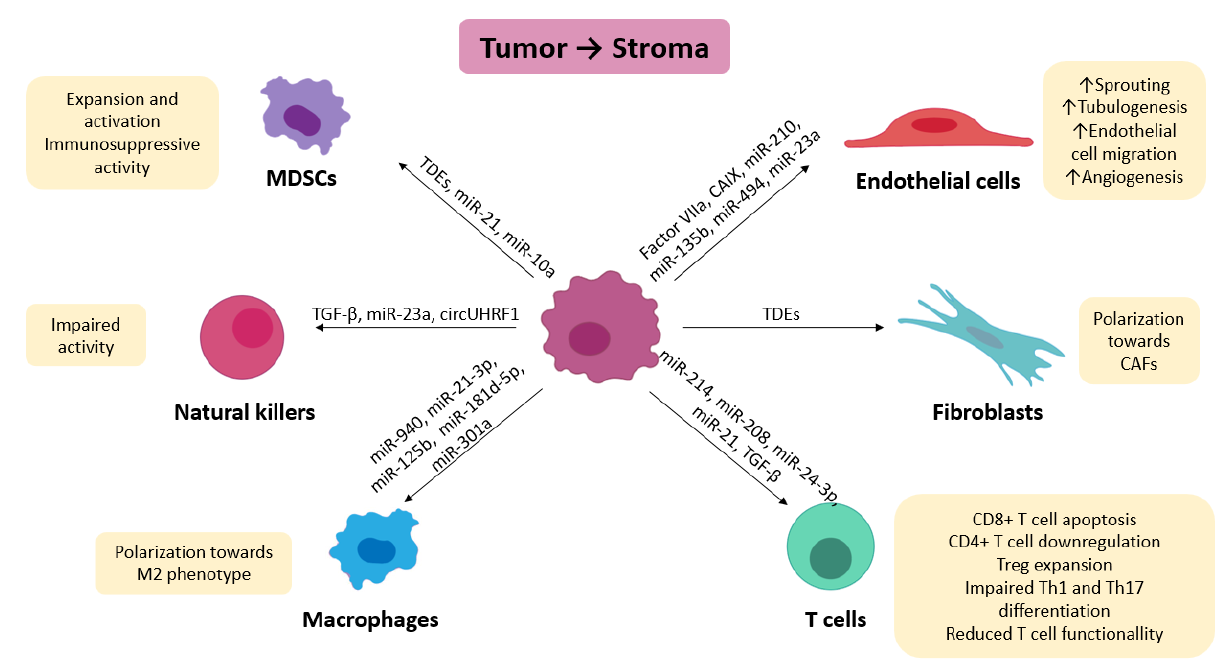
Figure 2. Exosomal communication of tumoral cells with stromal cells.